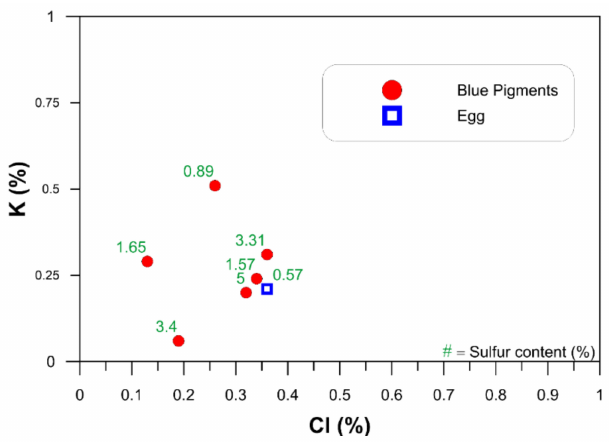
Figure 6. Comparison between elemental composition (K, Cl, S) of blue samples and hen egg (yolk and white, mixed).